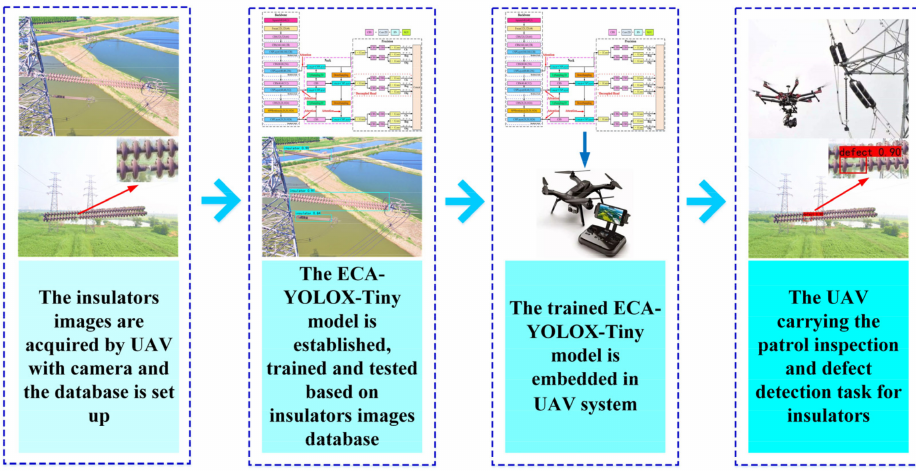
Figure 1. The flow chart of insulator defect detection based on